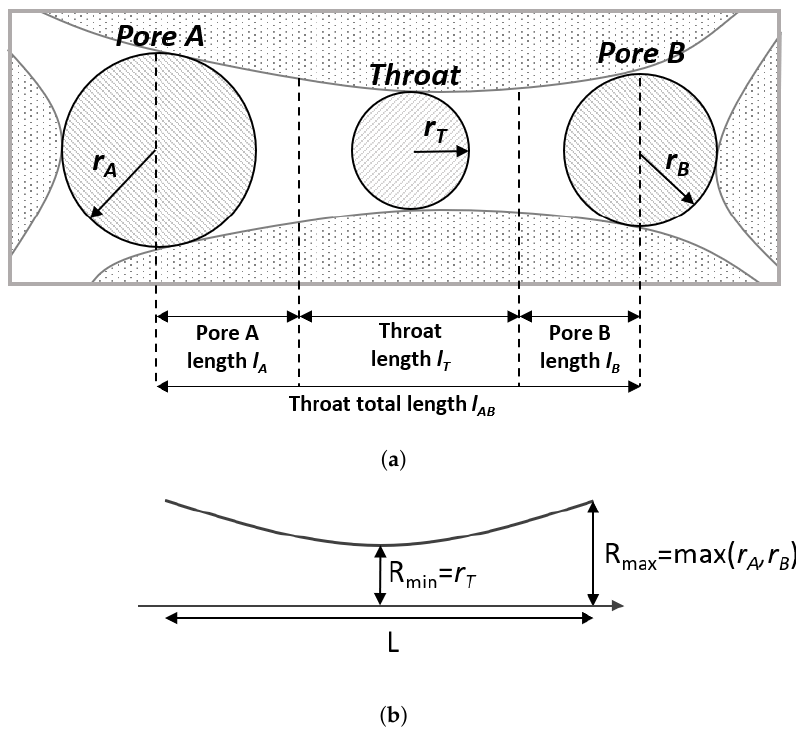
Figure 6. Pore throat adaptation for the proposed model. ( a ) Pore body and throat dimensions following the pore-network extraction method proposed by Dong [48]. ( b ) Pore throat dimensions for the adapted pore-network, based on pore body and throat radii in ( a ).